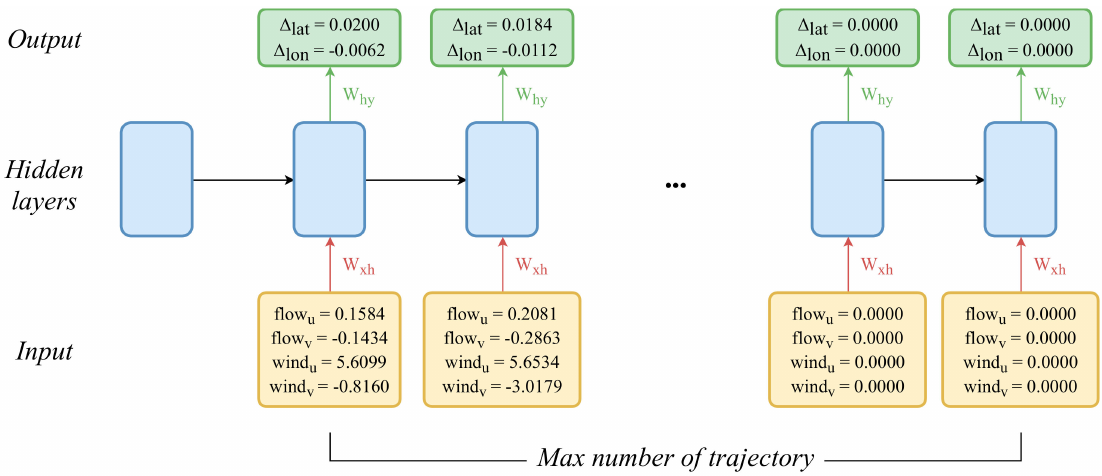
Figure 3. Data input / output in our recurrent neural network (RNN)